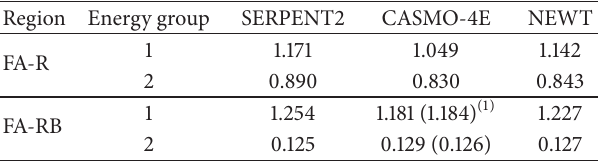
Table 7: The assembly discontinuity factors for each